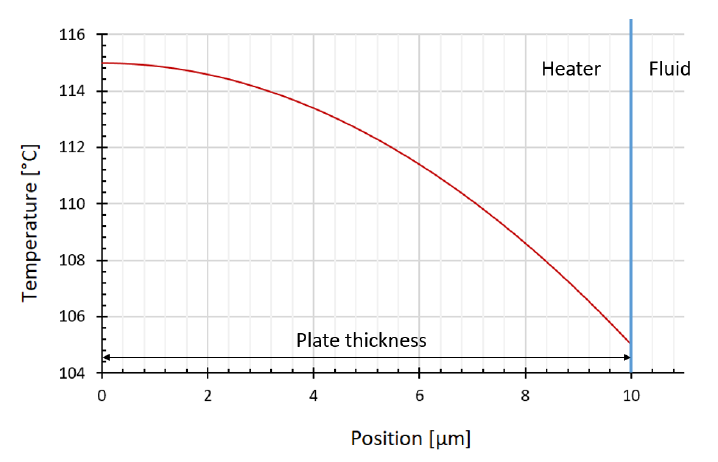
Figure 11. The 1D steady-state problem–solution: the temperature within the plate (thickness 10 µm). Equations (13)–(15) are solved by finite differences using a second-order-centered scheme for the Laplacian and an implicit scheme for time dependence. The temperature T ( 0, t ) is then calculated. This temperature will be noticed T dry